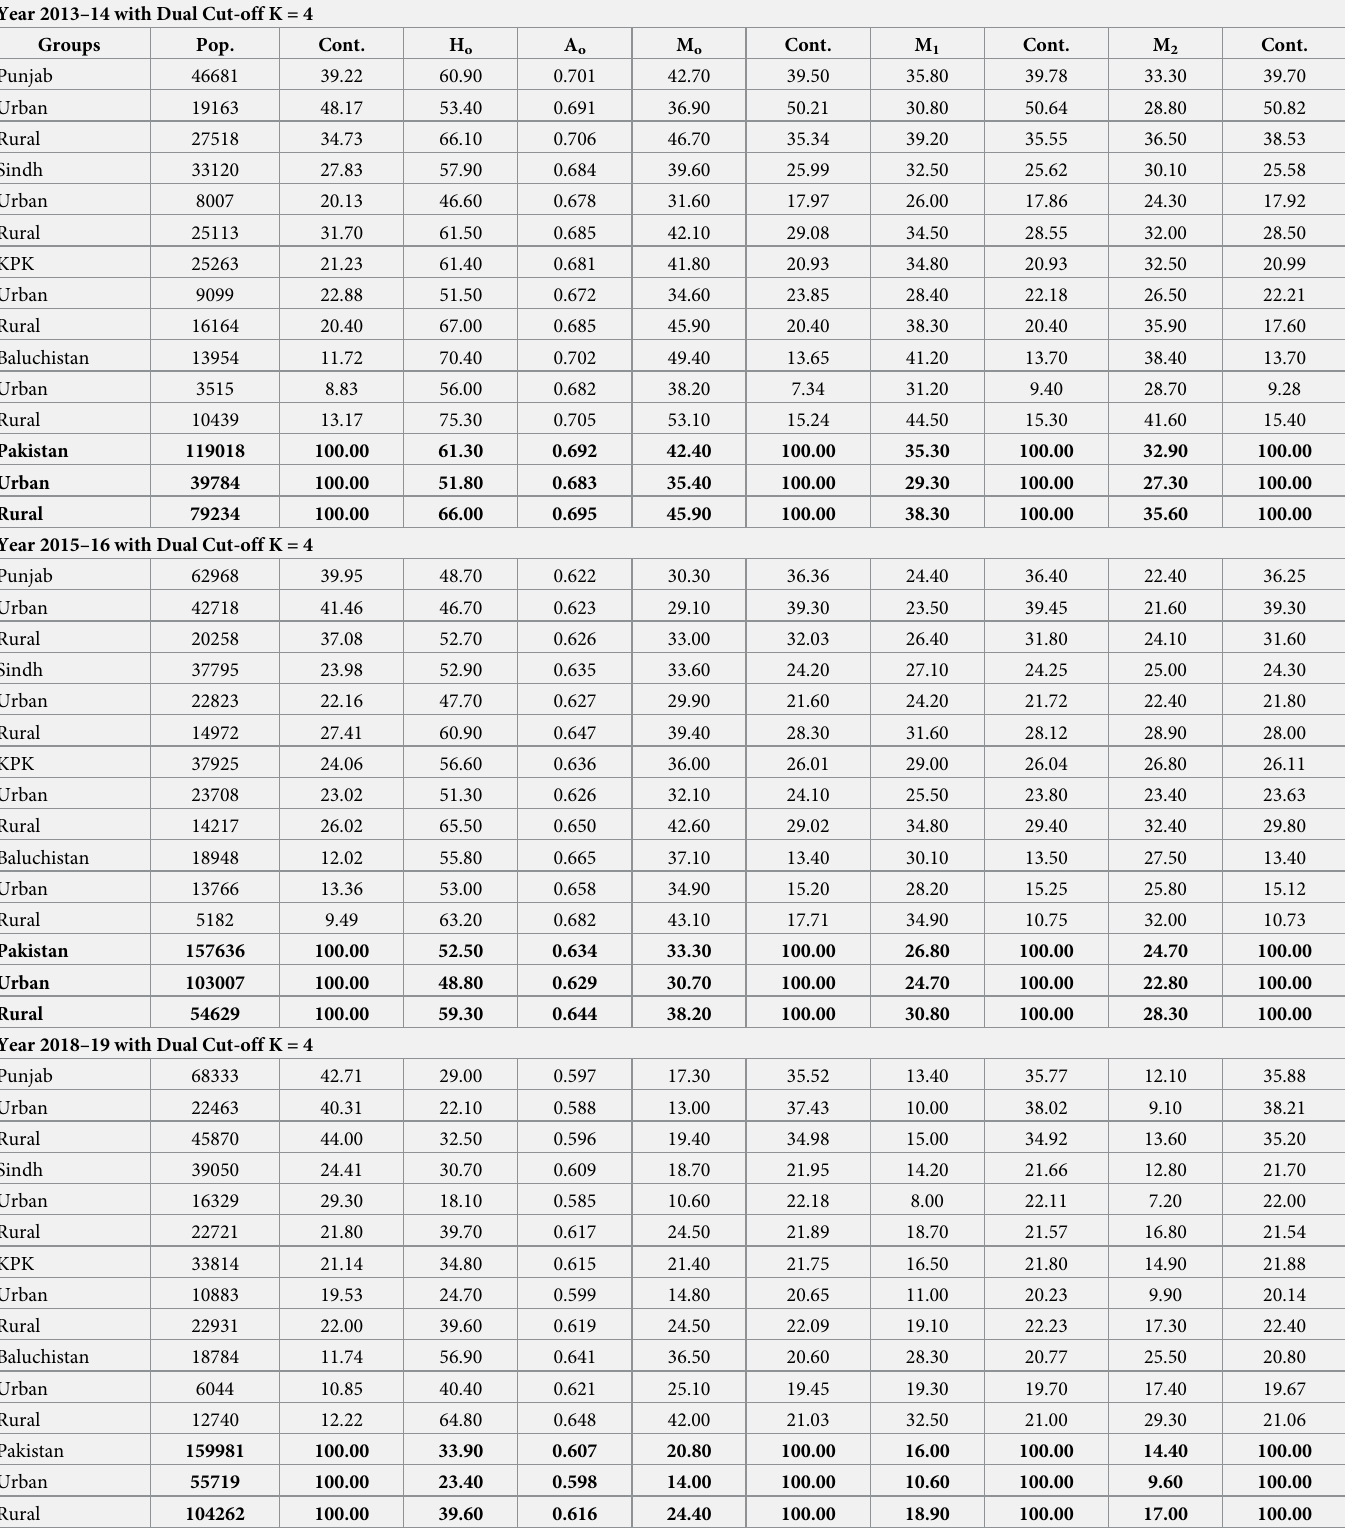
Table 2. Profile of multidimensional health poverty in Pakistan: 2013–14 to 2018–19. Year 2013–14 with Dual Cut-off K = 4 Groups Pop.